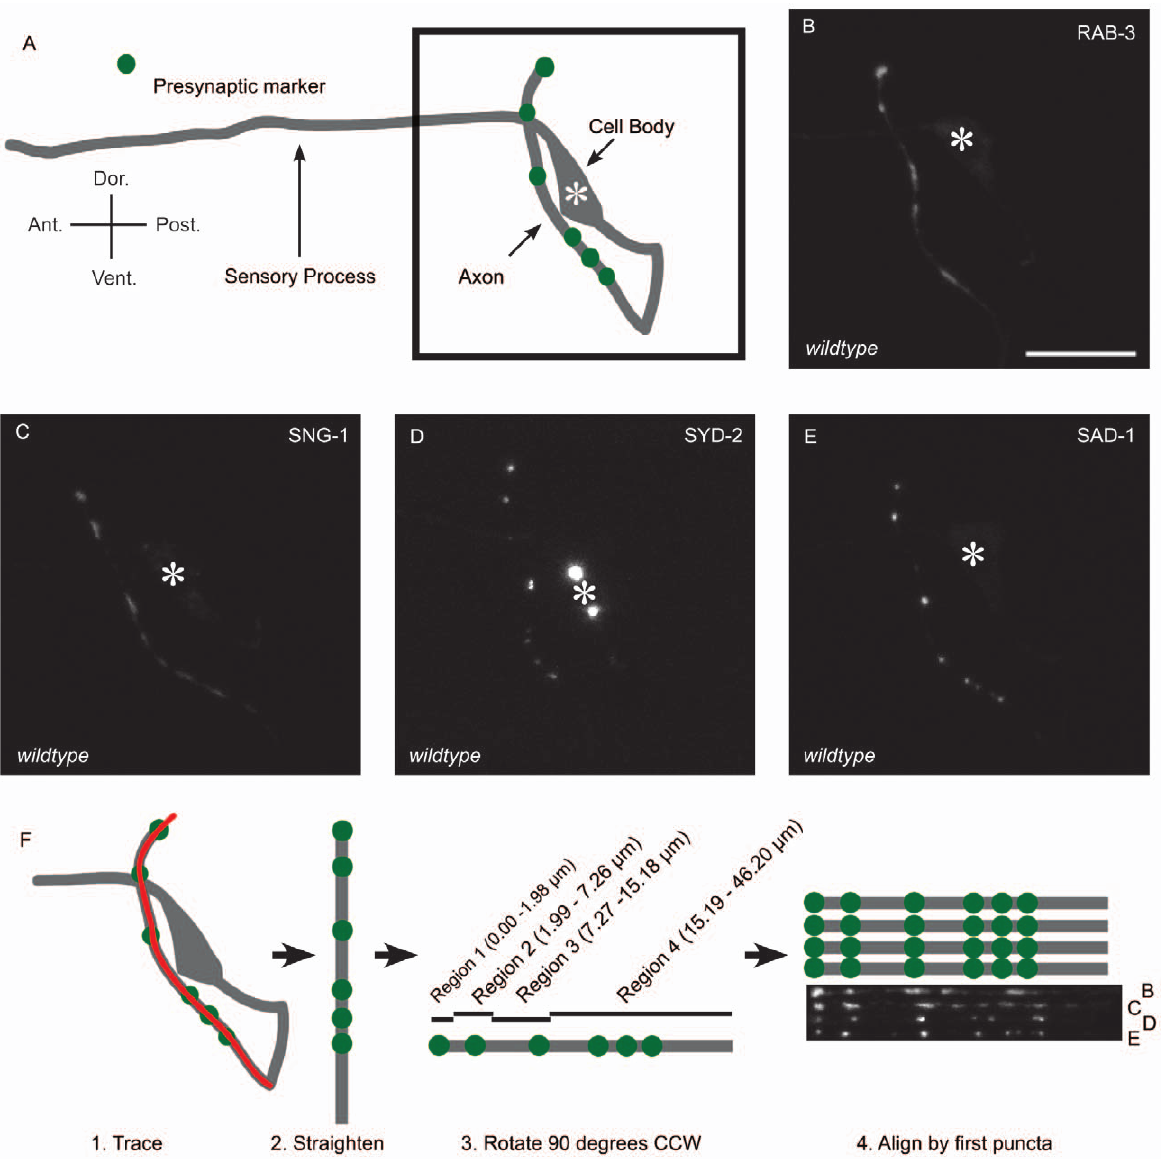
Figure 1. Multiple presynaptic components in AFD localize in a stereotyped pattern. (A) Schematic of AFD. A sensory process, referred to as the dendrite, extends anteriorly from the cell body. A second process, referred to as the axon, extends posteriorly and ventrally, then fasciculates with the nerve ring, where it forms synapses onto its sole post-synaptic partner, the interneuron AIY. Green dots, presynaptic specializations. RAB-3 (B), SNG-1 (C), SYD-2 (D), and SAD-1 (E) localization in AFD. Asterisk, cell body; scale bar, 10 m m. (F) Image processing workflow. Axons of confocal projections were traced (red line) and straightened using ImageJ. Straightened traces were then rotated 90 degrees counter clockwise and aligned by the center of the dorsal-most puntum of each animal. Regions were assigned based on stereotyped localization of presynaptic